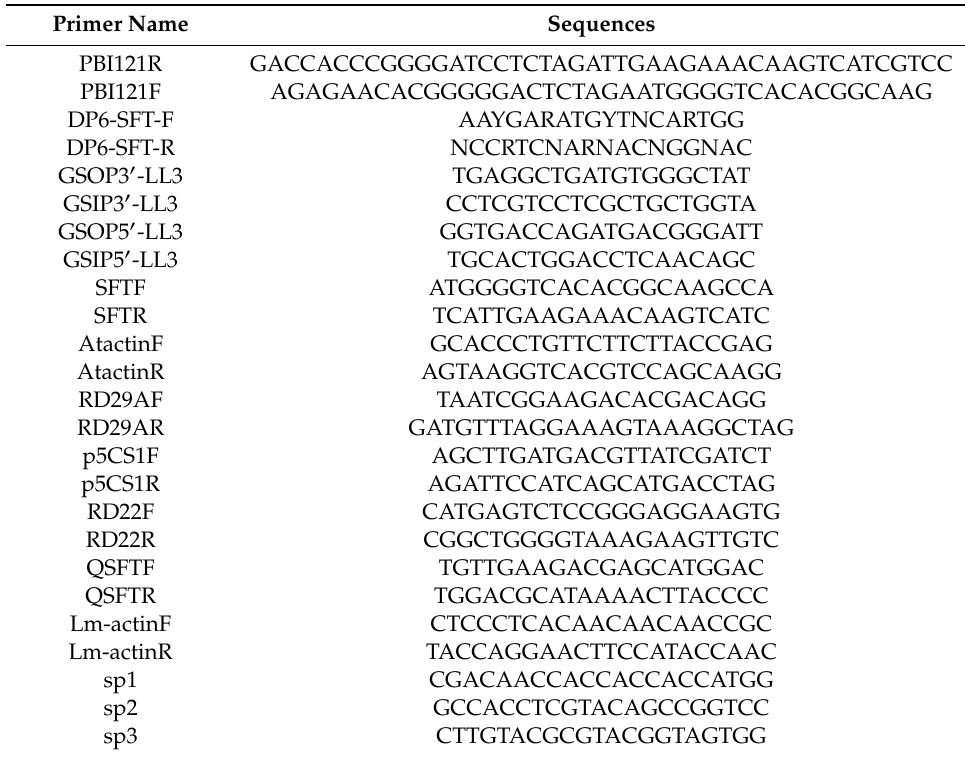
Table 1. Primers used in this